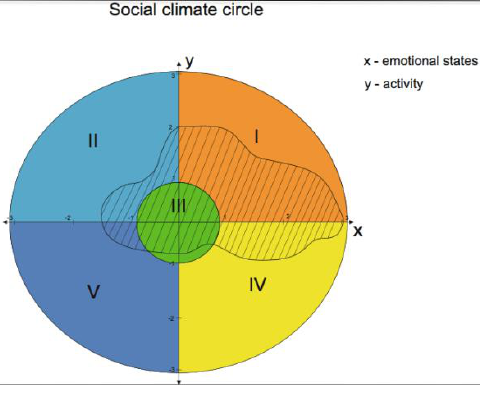
Figure 1: Social climate